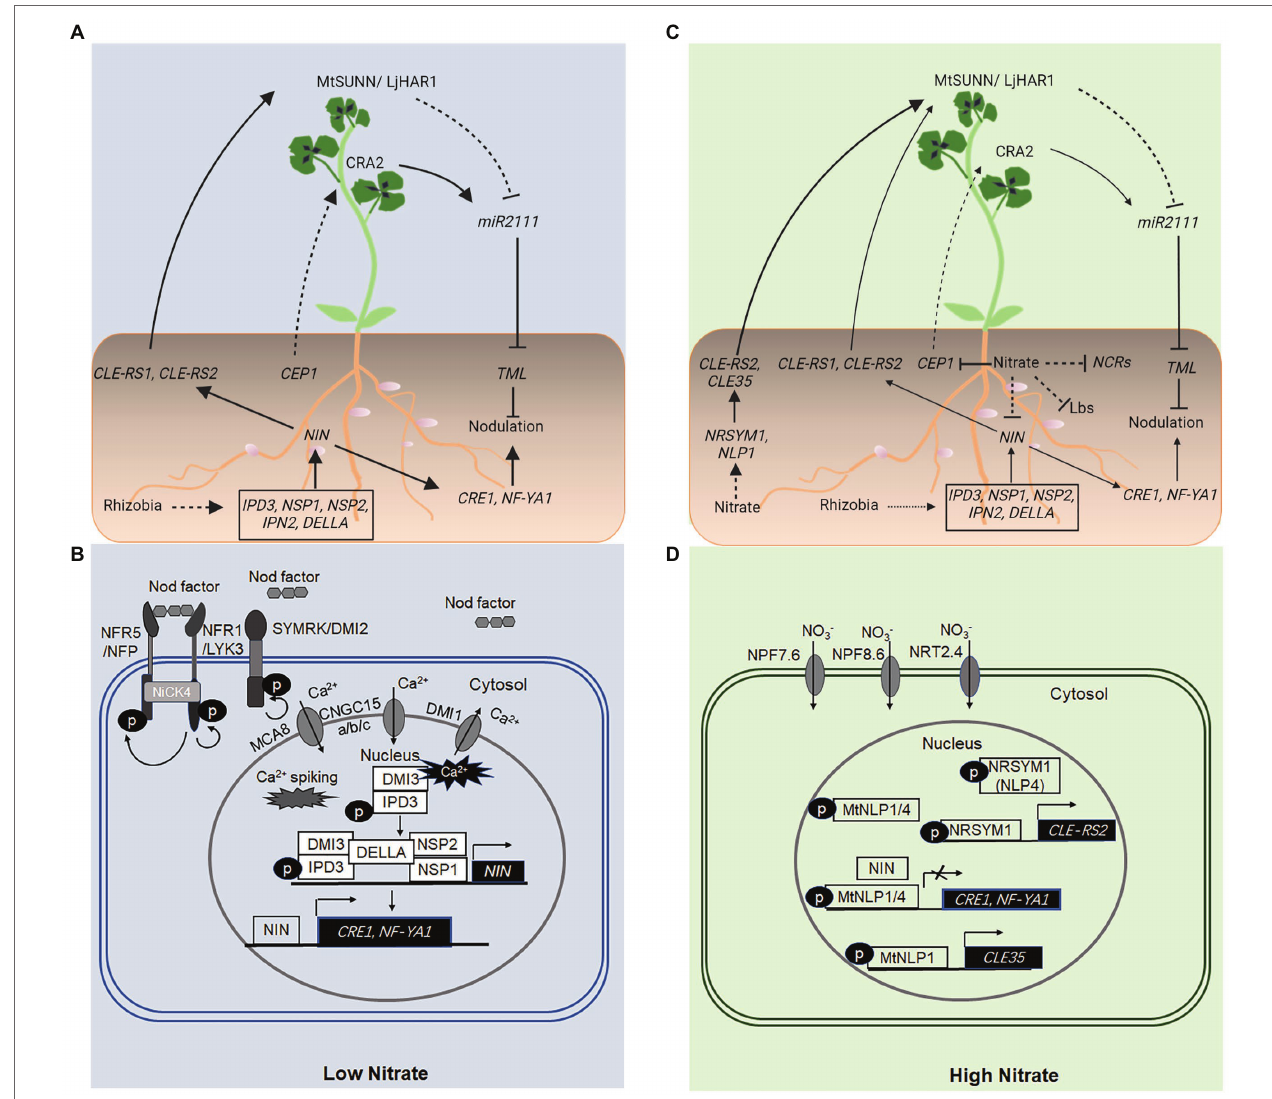
FIGURE 1 | Local and long-distance, systemic regulation of nodulation using NODULE INCEPTION (NIN) and NIN-like proteins (NLPs). (A,B) Under conditions of low nitrate (NO 3 − ), NIN activation is downstream from the initial perception of rhizobial nod factors by the LysM receptor-like kinases NFR1 and NFR5 in Lotus japonicus and LYK3 and NFP in Medicago truncatula , localized in the plasma membrane of root epidermal cells. Nodulation factor (NF) perception and signal transduction also require the LRR-RLK, SYMRK/DMI2, a cytoplasmic receptor-like kinase, NFR5-INTERACTING CYTOPLASMIC FORWARDING4 (NICK4), and a perinuclear Ca 2+ oscillation (Ca 2+ spiking) mediated by several proteins, including DOES NOT MAKE INFECTION1 (DMI1), CNGC15a/b/c, and MCA8 located in distinct nuclear membranes. The Ca 2+ oscillation is perceived by the CALCIUM/CALMODULIN-DEPENDENT PROTEIN KINASE (CCaMK), DMI3, which interacts with and phosphorylates the transcription factor CYCLOP/IPD3. DELLA proteins promote DMI3–IPD3 interactions and phosphorylation of IPD3, and interactions between IPD3–NSP2–NSP1 complexes, which bind distinct cis -elements in the promoter sequence of NIN and activate NIN expression. The NF-induced NIN activation upregulates the expression of downstream genes including NF-YA1 and CRE1 , which are essential for rhizobial infection and nodule organogenesis, respectively. NIN also binds directly to the promoter sequence and activates the expression of genes encoding CLE-like peptides such as CLE-RS1 and CLE-RS2 in L. japonicus , which are transported from the root to shoot, where they are perceived by the LRR-RLK, LjHAR1/MtSUNN. This leads to a reduced level of the mobile signal, miR2111 in the shoot and the root, and a corresponding increase in the transcript level of the miR2111 target, TML , which encodes a negative regulator of nodule initiation in the root. Conditions of low nitrogen (N) also activate a CEP1-CRA2 systemic pathway, which positively regulates the nodule number. (C,D) A high level of NO 3 − inhibits nodulation both locally and systemically. A high level of NO 3 − activates the expression of genes encoding the NLPs, NLP1, and NITRATE UNRESPONSIVE SYMBIOSIS1 ( NRSYM1 ; NLP4 ), which directly activate the expression of genes encoding CLE35 and CLE-RS2 peptides in M. truncatula and L. japonicus , respectively. CLE-RS2 and CLE35 peptides function to inhibit the number of nodules formed on roots via the LjHAR1/MtSUNN-dependent autoregulation of nodulation (AON) pathway. A high level of NO 3 − also suppresses the CEP1 gene expression, diminishing the activity of a CEP1-CRA2 systemic pathway in the nodule number regulation. (D) Under conditions of high NO 3 − , NLPs (NLP1–NLP4 in M. truncatula ) are activated and accumulate in the nucleus, where they interact with NIN and compete with NIN for binding sites in promoter sequences of target genes or both. As a result, the expression of NIN-activated genes including CRE1 and NF-YA1 is suppressed, inhibiting nodulation. A high level of NO 3 − also suppresses the expression of nodule cysteine-richs ( NCRs ) and LEGHEMOGLOBIN (Lbs) , which results in the inhibition of nitrogenase activity. Solid and dashed lines indicate the processes that are supported by experimental evidence and putative, respectively. The size of the arrows indicates the relative strength of the signaling